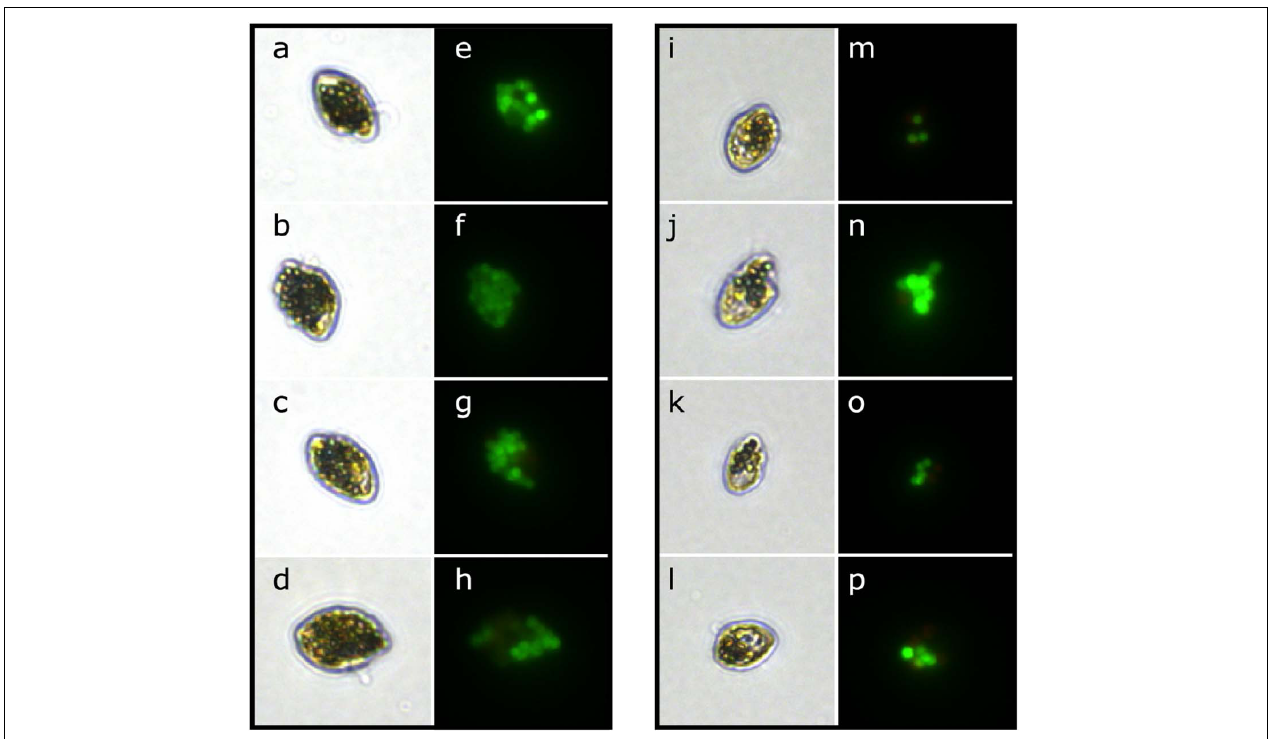
FIGURE 1 | Micrographs of the heterotrophic dinoflagellates O. marina (left column) and Gyrodinium sp. (right column) with microplastic beads (fluorescent green) ingested under light (a–d,i–l) and epifluorescence (e–h,m–p)